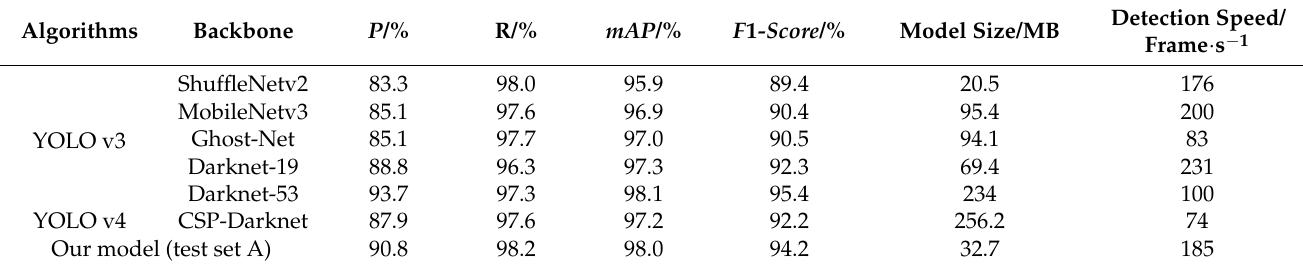
Table 2. Detection results of ginger using different single-stage detection